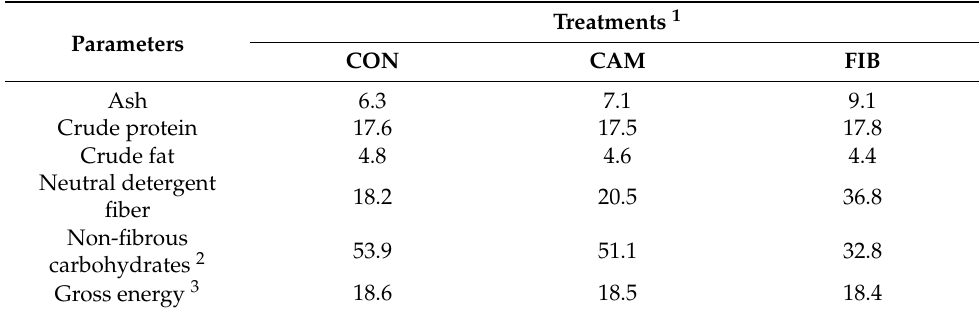
Table 1. Chemical composition (%) and gross energy content (MJ/kg) of the experimental diets (values on dry matter basis).